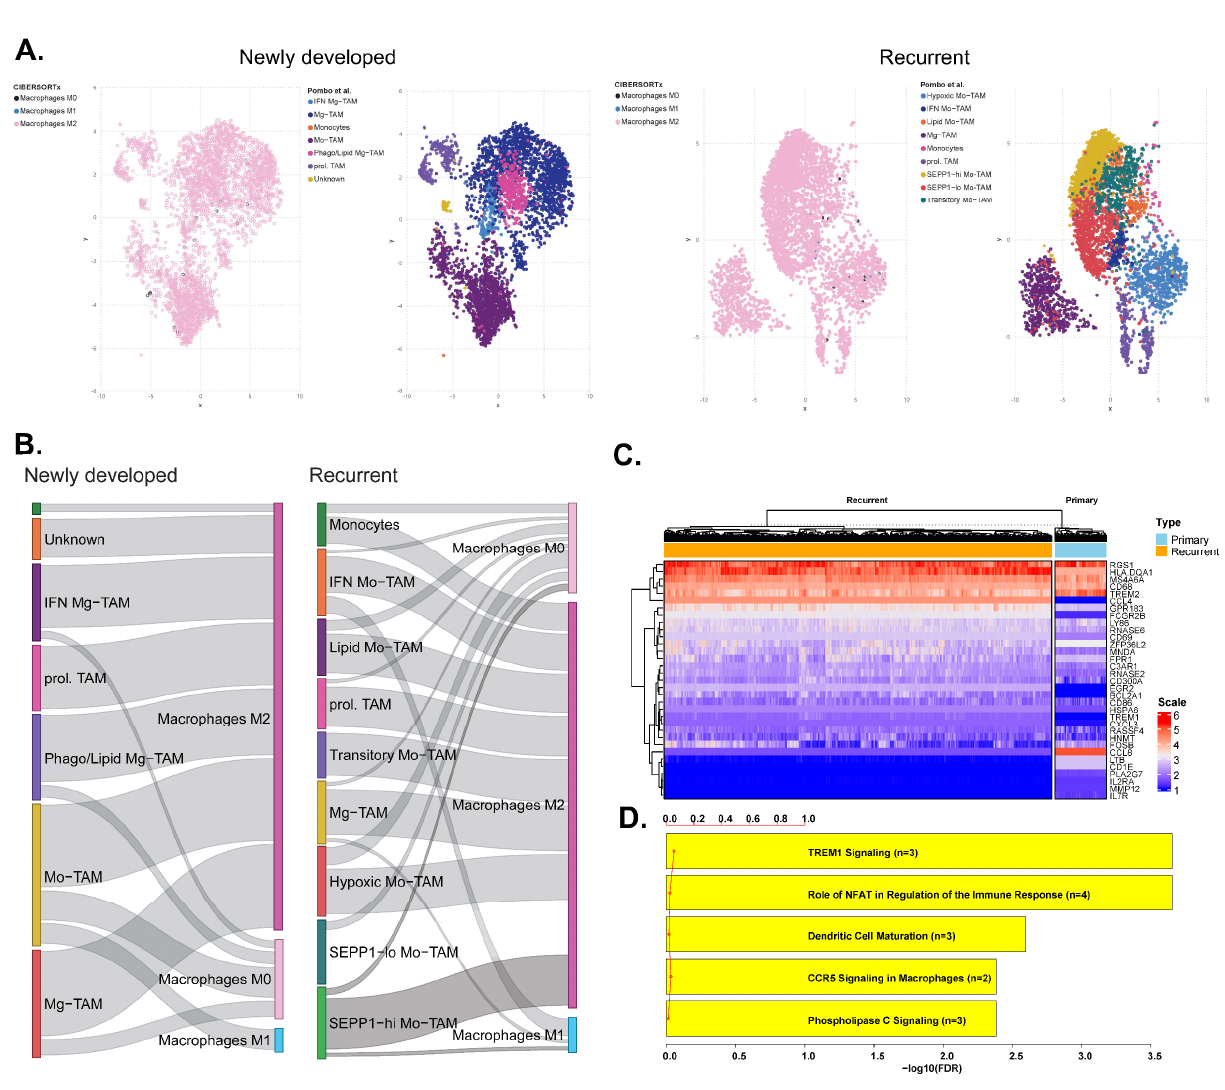
Figure 3. From the brain immune atlas dataset, immune cells classified by CIBERSORTx and those reported by Pombo et al. [24] are compared for newly developed and recurrent glioblastoma in scatter plots ( A ) and a Sankey diagrams ( B ). ( C ) Heatmap showing macrophage gene expression patterns between primary and recurrent glioblastoma from the brain immune atlas dataset. ( D ) Gene set enrichment analysis for differential genes of macrophage between primary and recurrent